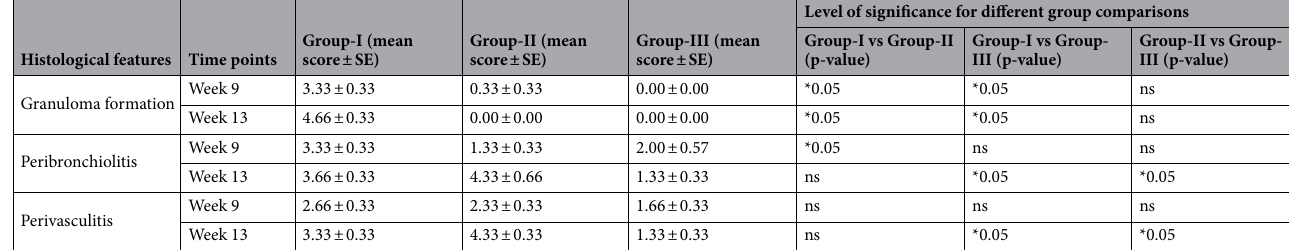
Table 1. Comparative histological scoring of different study groups. Mean score was calculated from 3 animals in each group. The data was represented as Mean ± SE of 3 animals in each group and the statistical significance was determined by Mann–Whitney test. *p ≤ 0.05. ns-non-significant. Group-I: latent tuberculosis only, Group-II: latent tuberculosis with diabetes and Group-III: latent tuberculosis with immunosuppression.